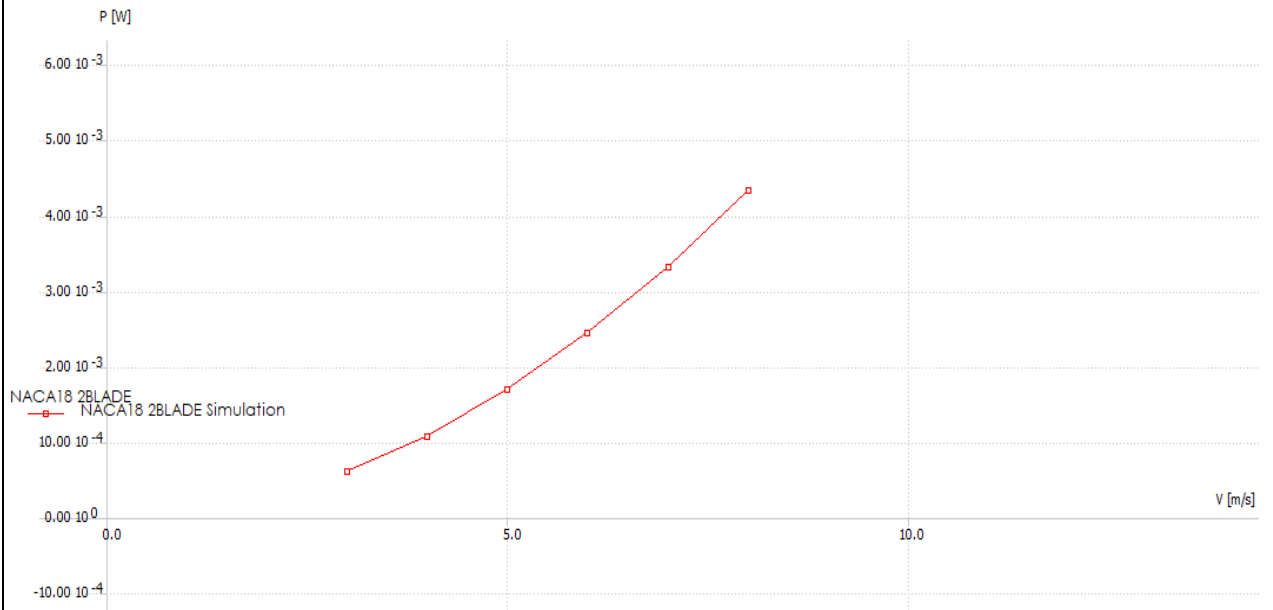
Figure 21. Torque vs wind speed for 2 Bladed